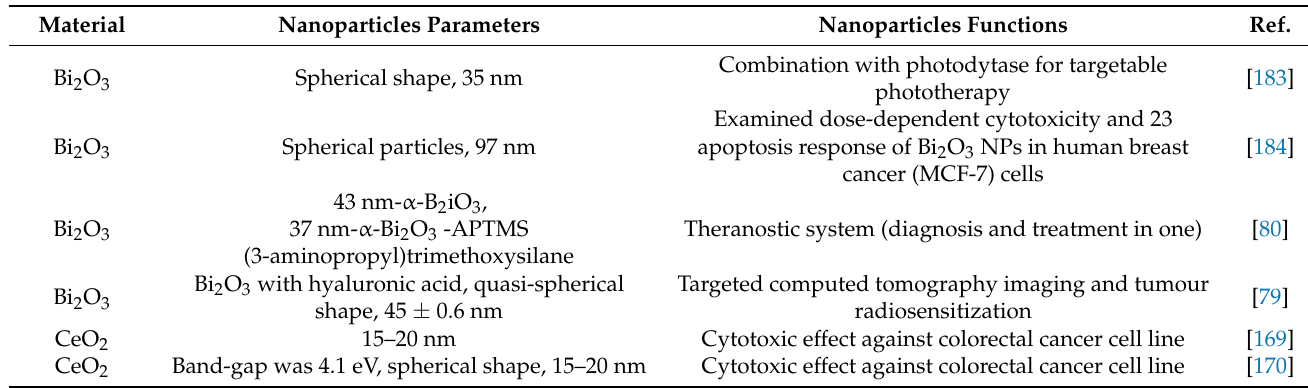
Table 2. Metal oxide nanoparticles used in anti-cancer therapies. Nanoparticles Parameters Nanoparticles Functions Ref. Combination with photodytase for targetable Spherical shape, 35 nm phototherapy Examined dose-dependent cytotoxicity and